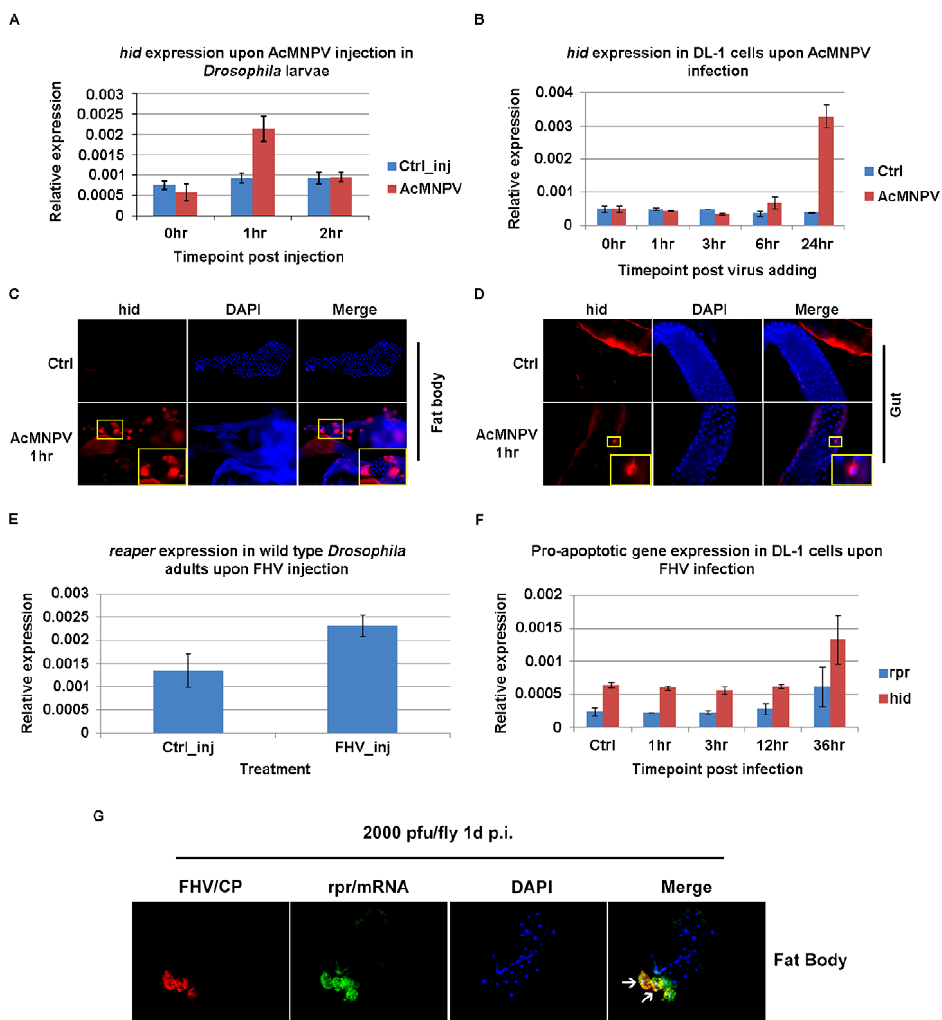
Figure 2. Rapid induction of reaper and hid following viral infection of Drosophila larvae or adults. A. At 1 hr post AcMNPV injection, hid mRNA level in injected larvae was induced , 2 fold. By 2 hr p.i., the level of hid went back to normal. B. AcMNPV infection in cultured DL-1 cells (MOI=20) did not induce r eaper/hid until a relative late stage (24 hr p.i.). Data are shown as mean 6 SD of two to three independent experiments. C. hid was induced in fat body cells as revealed by FISH using digoxin-labeled cRNA probe following AcMNPV injection. D. A few cells in the gut also had elevated hid expression following AcMNPV injection. E. At 1 hr post FHV injection, reaper mRNA level in infected adults was induced , 1.6 fold. F. FHV infection in DL-1 cells (MOI=40) did not induce reaper / hid expression until 36 hr p.i.. Data are shown as mean 6 SD. G. Cells expressing high levels of reaper mRNA (green, FISH) in the fat body were cells were also positive for the FHV capsid protein (red, arrows). DAPI was used to visualize the nuclei. The animal shown was of genotype Lsp-Gal4, UAS-diap1. Photos are representative of at least 2 independent